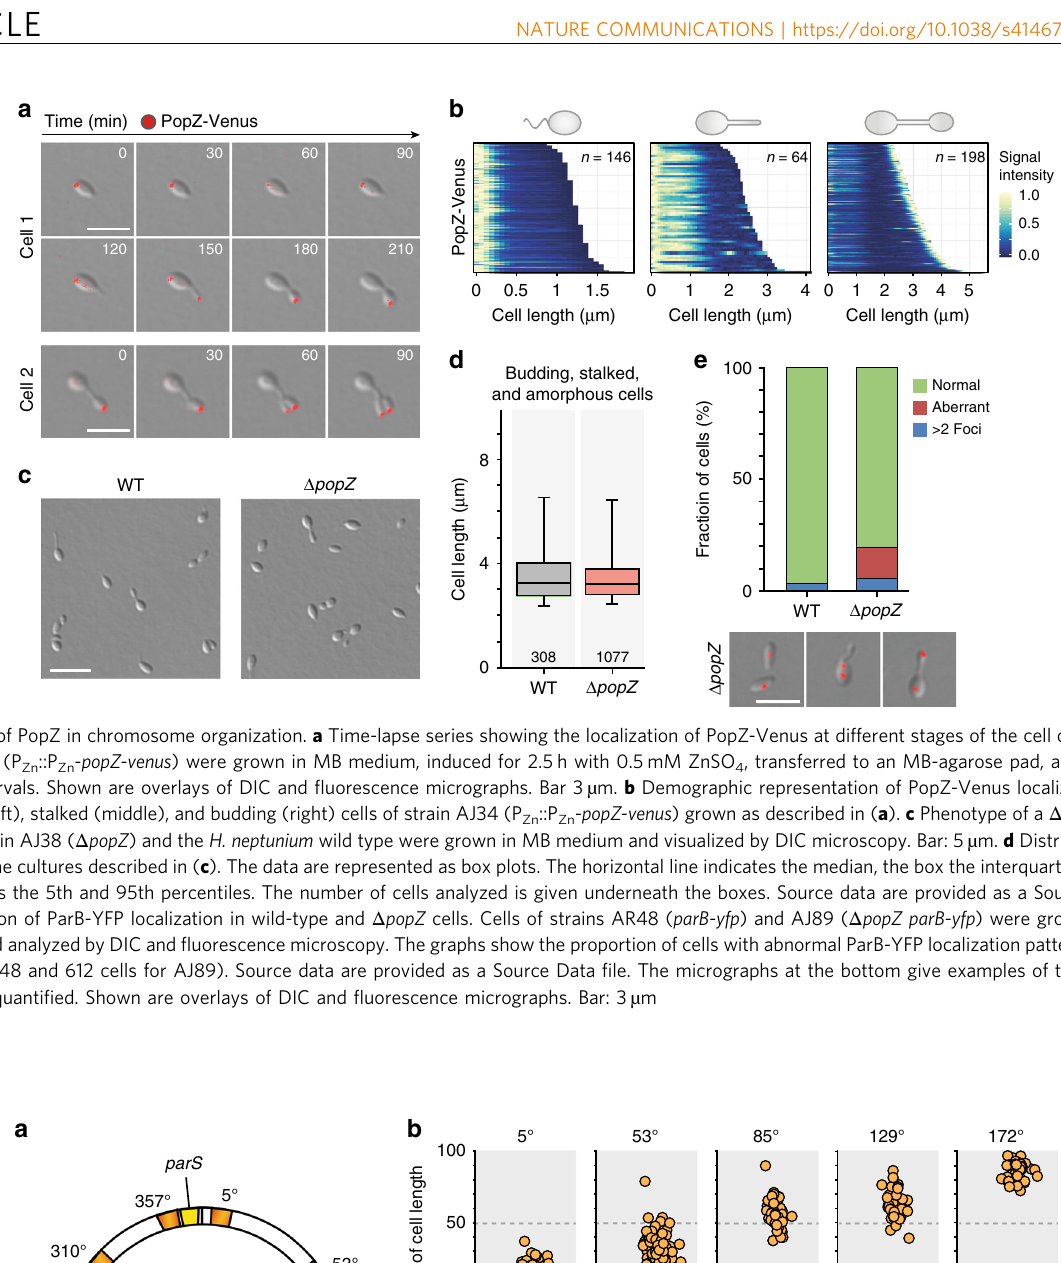
H. neptunium chromosome. Strains ( parB-yfp P Zn ::